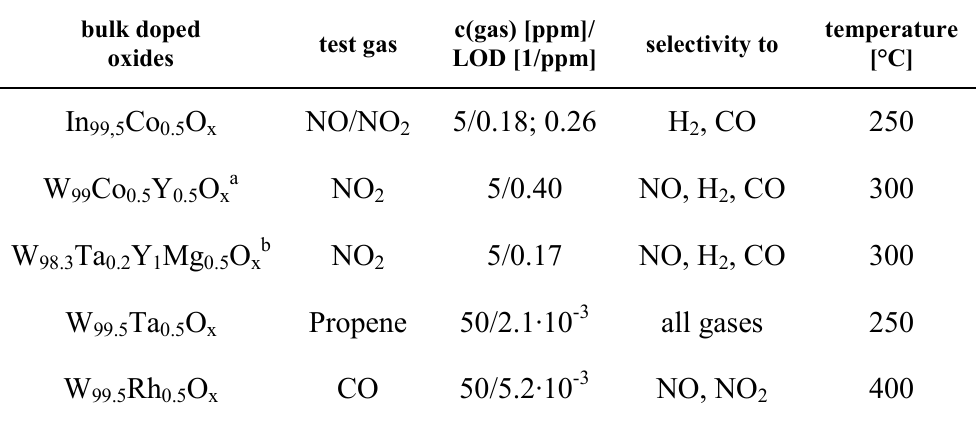
Table 3. Selection of selective single sensors based on the HT-IS